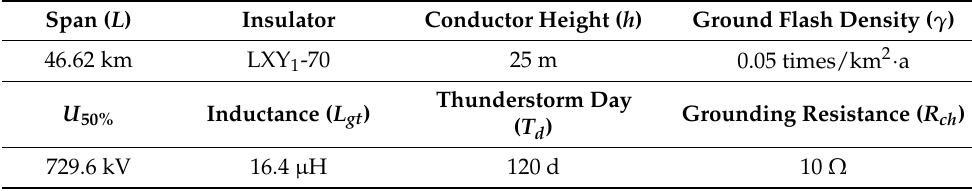
Table 7. Parameters of the transmission